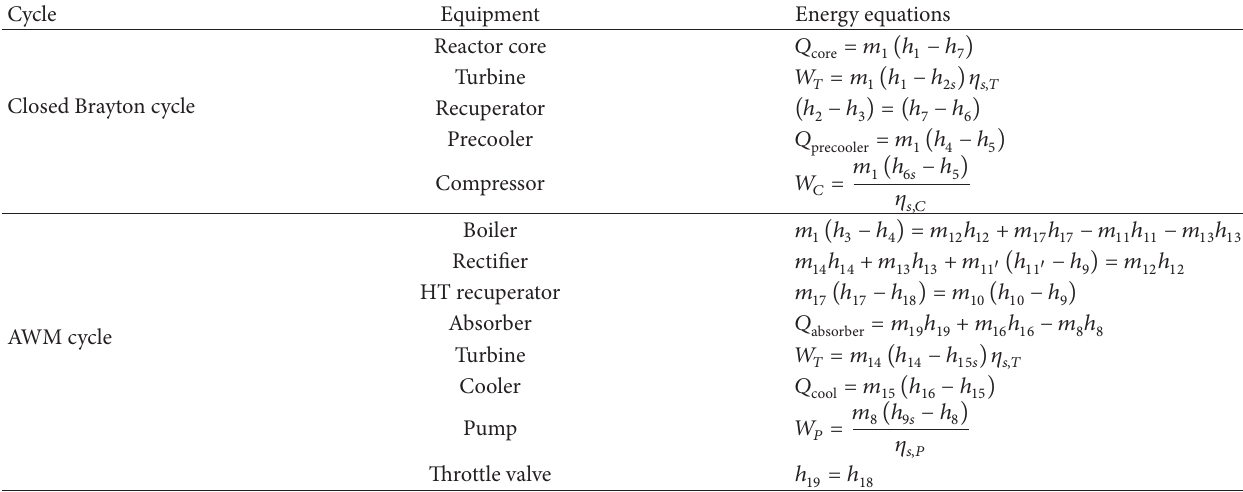
Table 1: Energy relations for the equipment of closed Brayton cycle and AWM